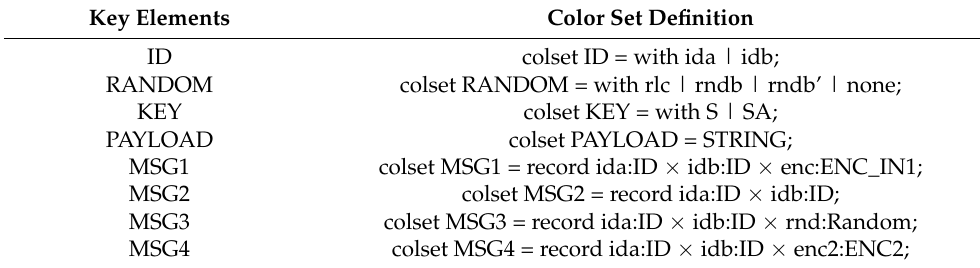
Table 3. EnOcean protocol color set